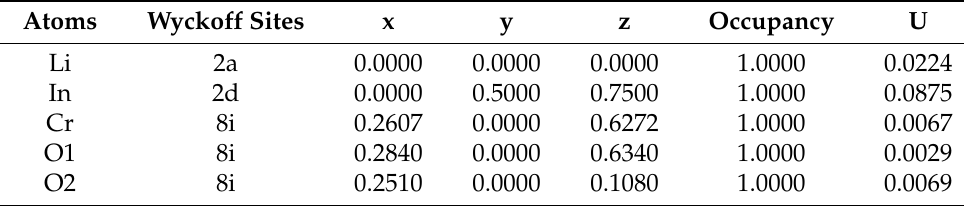
Table 6. The Wyckoff sites, fractional coordinates, and occupations as reported in an earlier study [8] and the thermal parameter U as obtained from Rietveld refinement of LiInCr 4 O 8 in the HP-1 phase at ∼ 14 GPa. Space group I¯4m2, Z = 2, a = 5.9030(26) Å, c = 8.0681(60) Å, and V = 281.13(22) Å 3